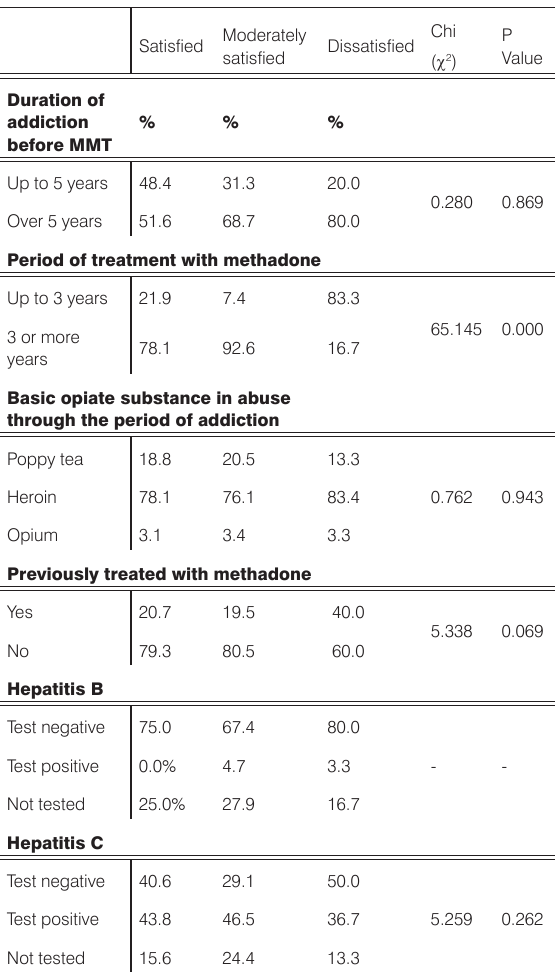
Table 2. Socio-demographic characteristics of the patients under methadone maintenance treatment and the level of social functioning Moderately Satisfied satisfied